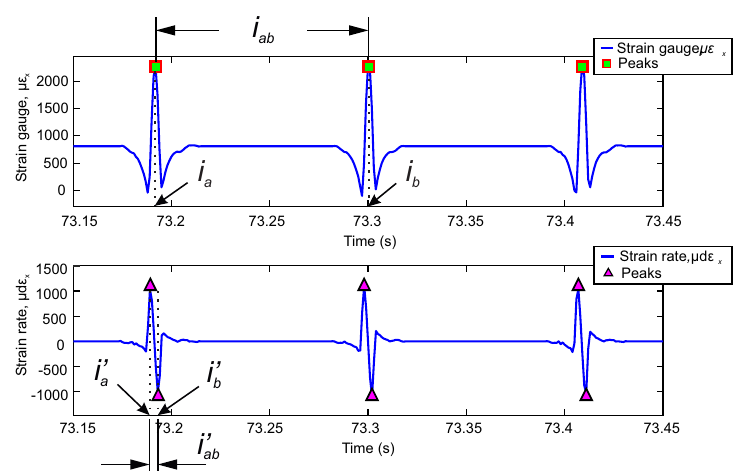
Figure 10. Calculation of the contact length using the strain curve in the circumferential direction (0.8 bar , 0 ◦ , 50 km/h, 500